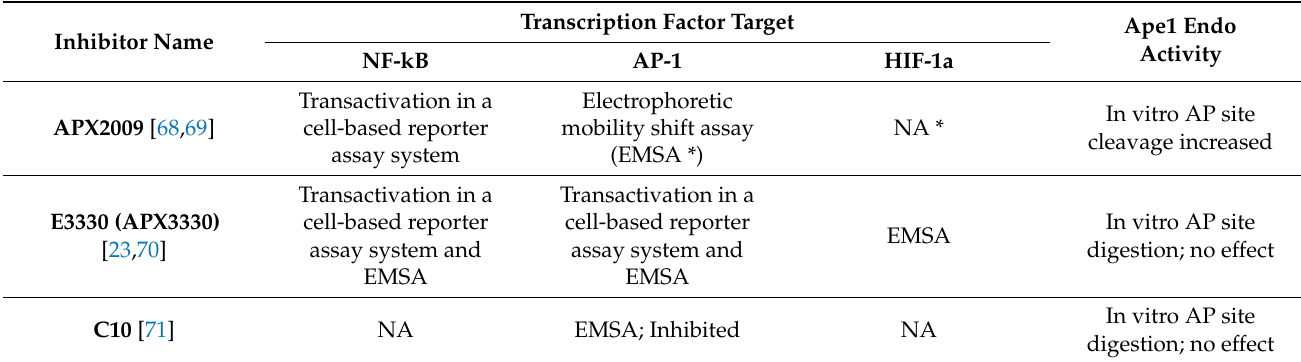
Table 2. Major Ape1 redox inhibitors and their